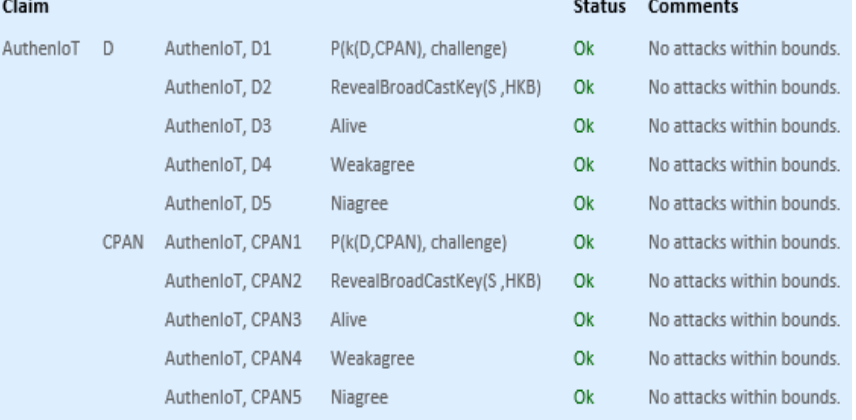
Figure 6. Formal validation results of our